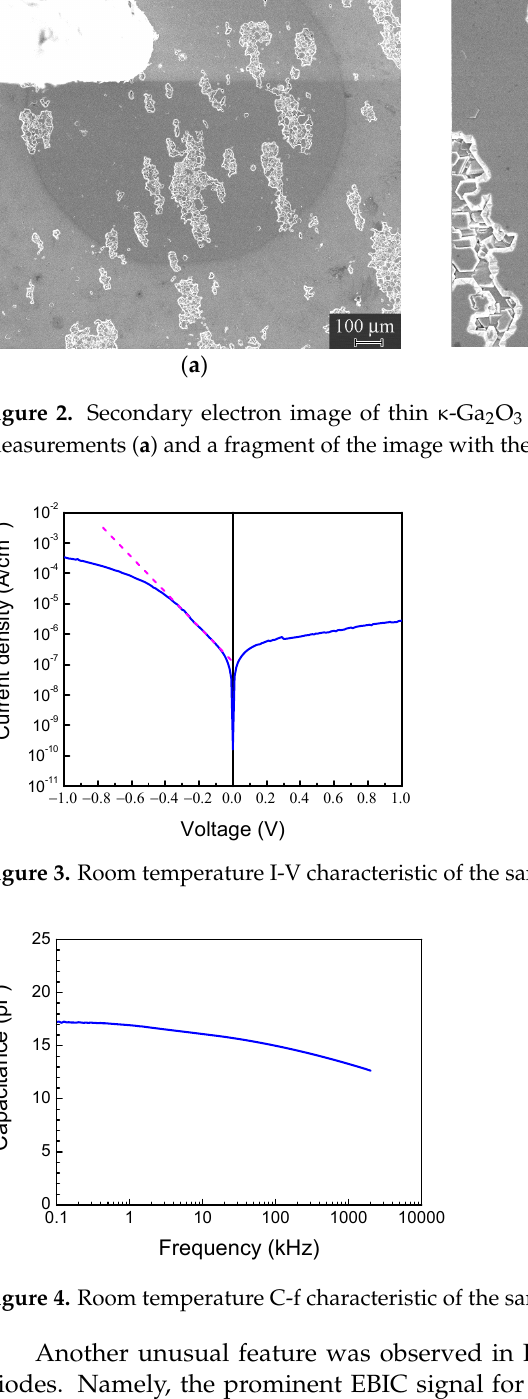
Figure 2. Secondary electron image of thin κ‐ Ga 2 O 3 film with the Schottky diode for electrical measurements ( a ) and a fragment of the image with the higher magnification ( b ).